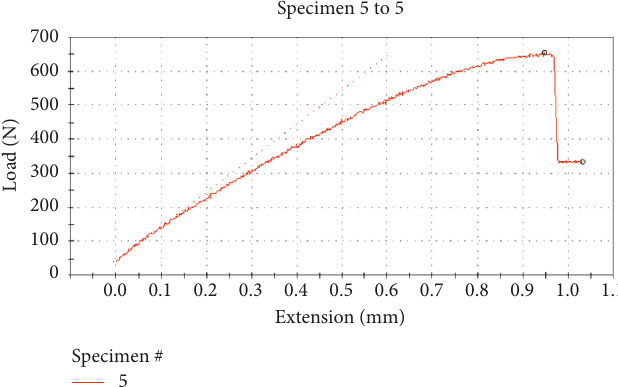
Figure 10: Tensile load-extension curve for specimen